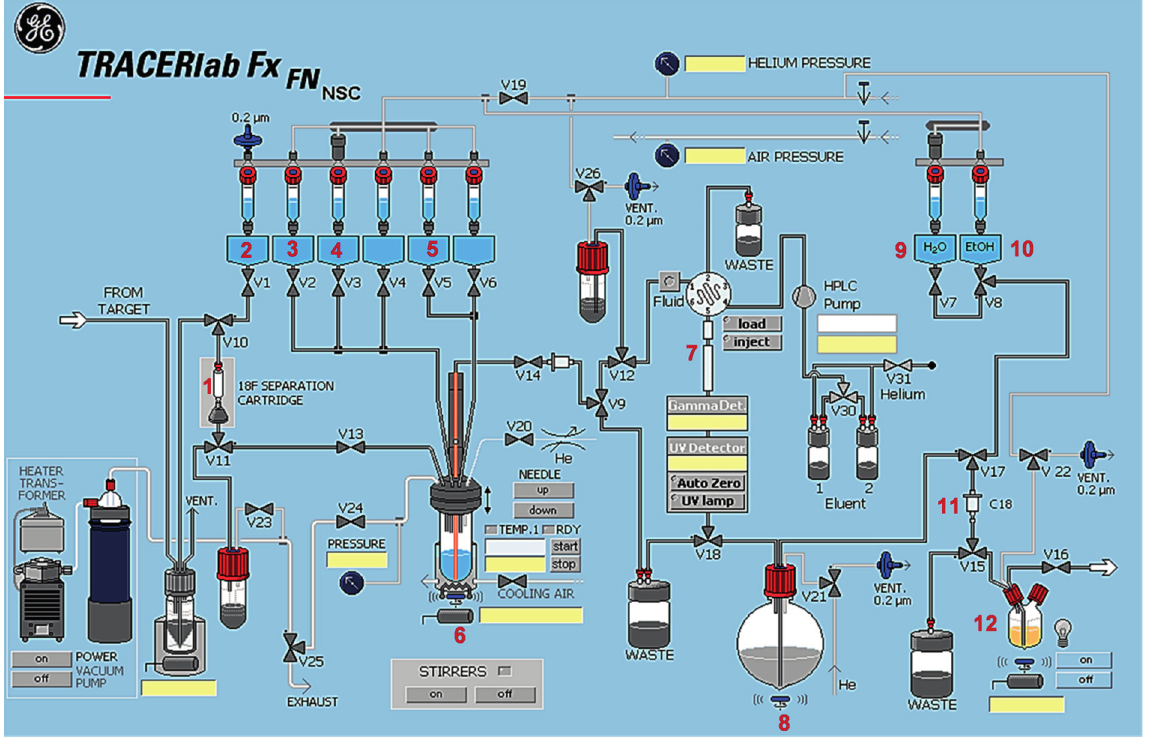
Scheme 3. Tracer Lab™ FX-FN synthesis module for the automated radiosynthesis